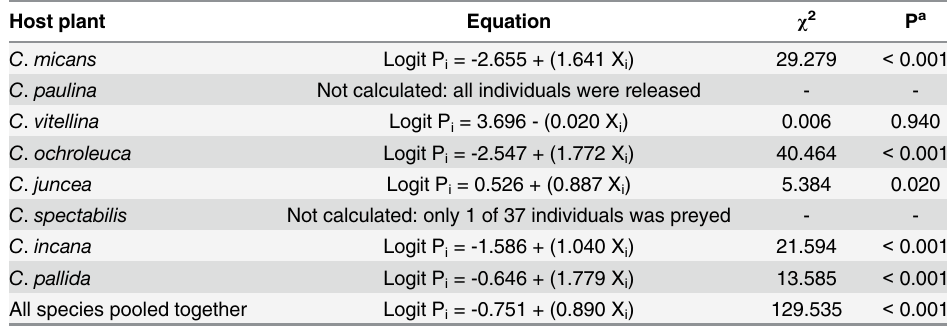
Table 4. Logistic regression results for the Nephila clavipes response (predation or release) in rela- tion to the concentration of pyrrolizidine alkaloids in adults of Utetheisa ornatrix fed as larvae on leaves or unripe seeds of eight host